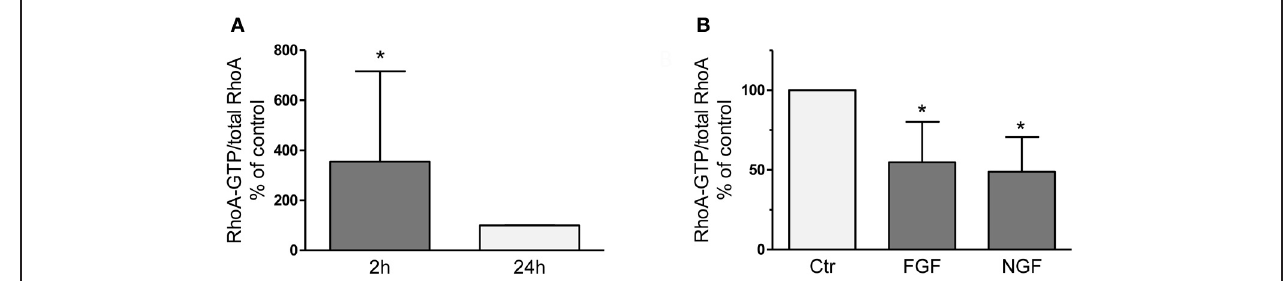
FIGURE 1 | RhoA-GTP pull down assays performed 2h or 24h after dissociation and plating of adult DRG neurons on a growth promoting substrate (A) . Compared to the 24h time point vehicle-treated naïve neurons